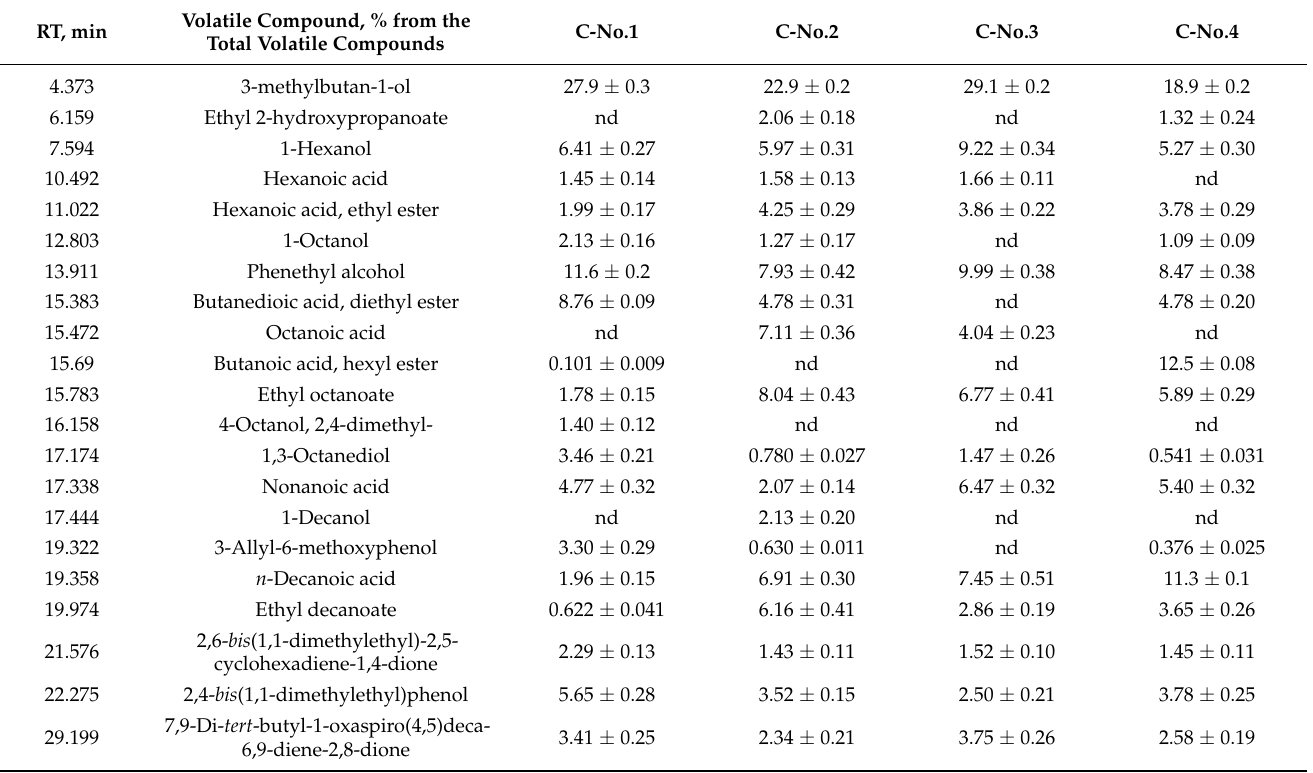
Table 12. Volatile compound profile (% from the total volatile compounds) of cider